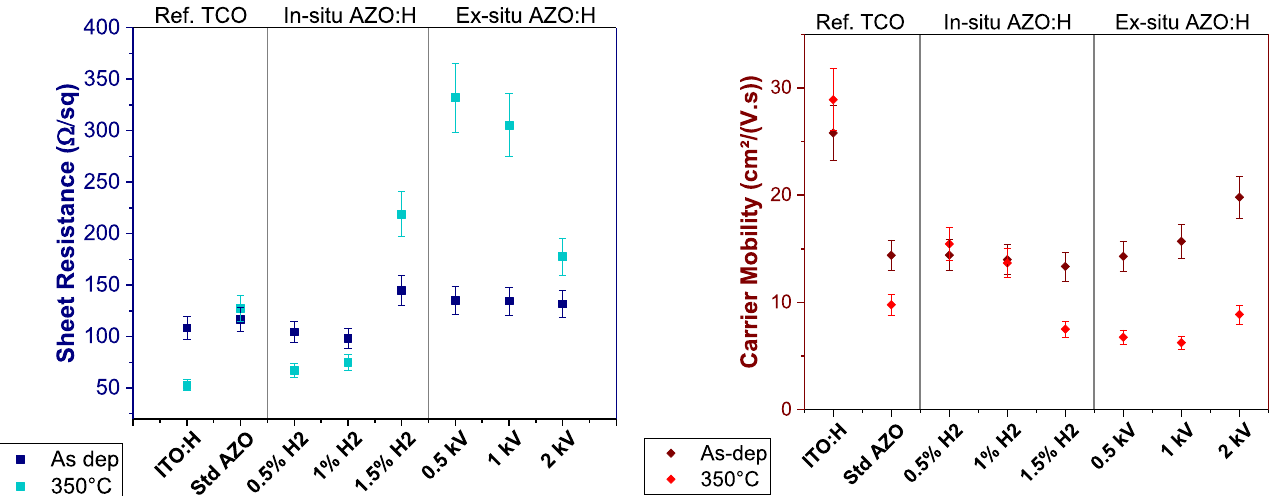
Fig. 4. Variation of charge carrier mobility with the TCO composition and the annealing at 350 ° C.